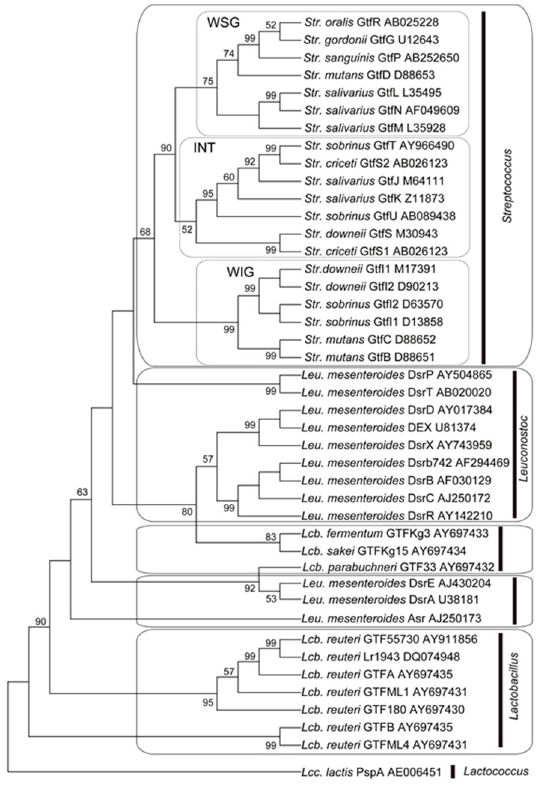
Figure 6. Phylogenetic analysis of glycosyl hydrolase family 70 enzymes by amino acid sequence. Cited from Reference [46] with permission.